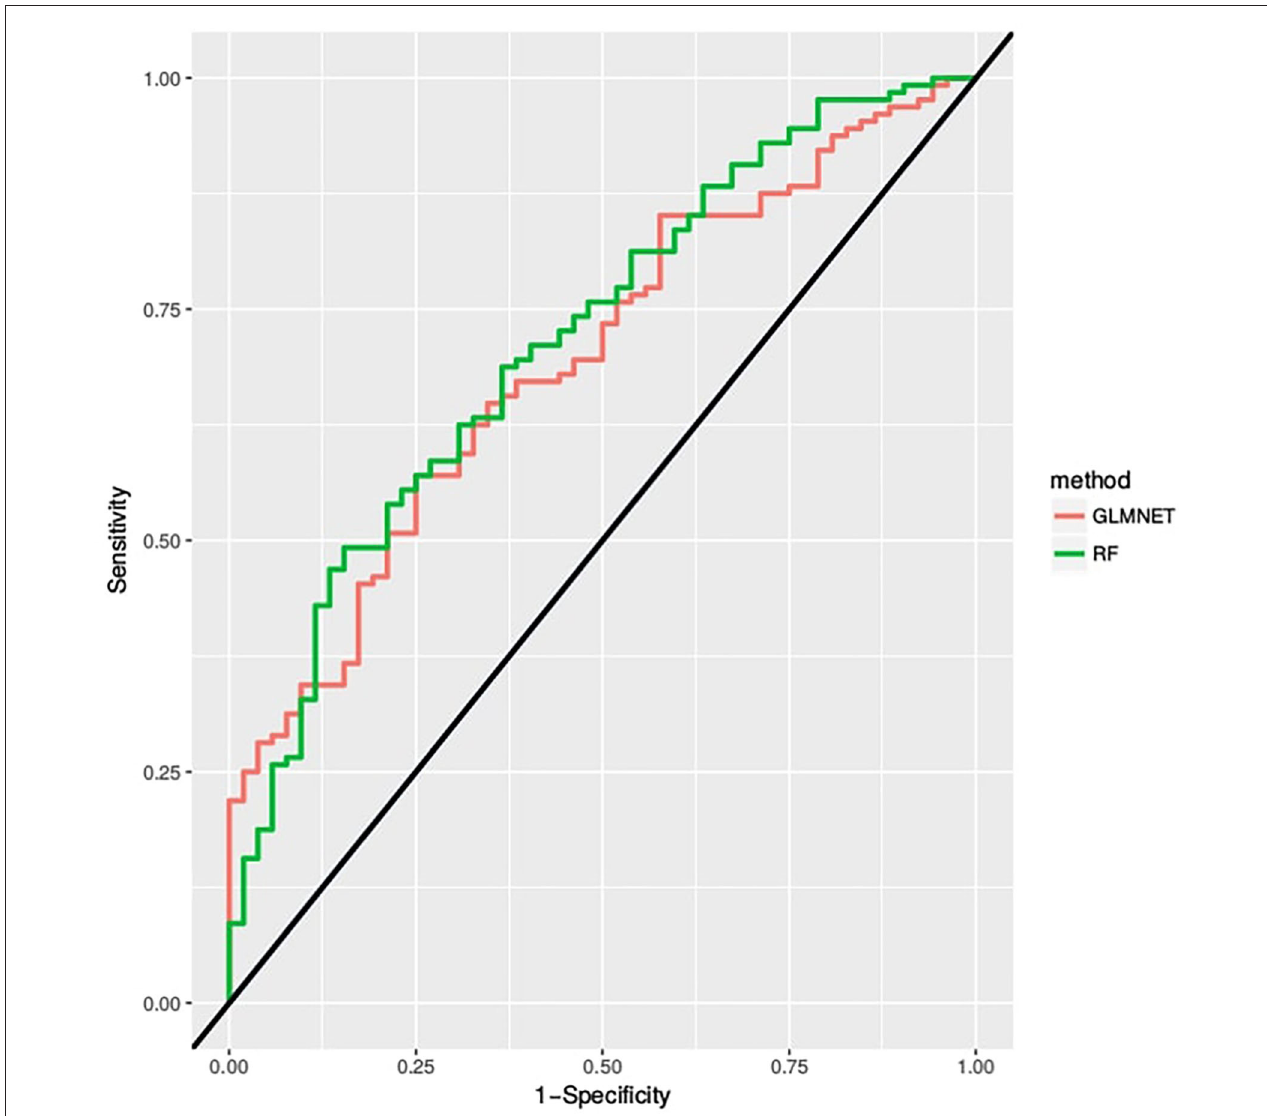
FIGURE 4 | The ROC curve is created by plotting the true positive rate (sensitivity) against the false positive rate (specificity) at various threshold settings.